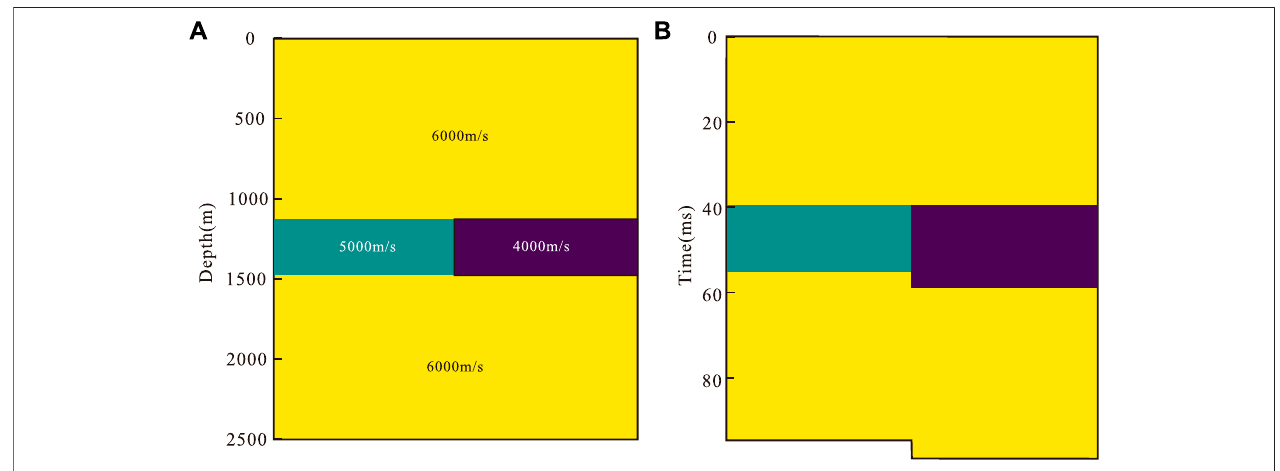
FIGURE 3 | Model comparison diagram. (A) Depth-domain model. (B) Time-domain